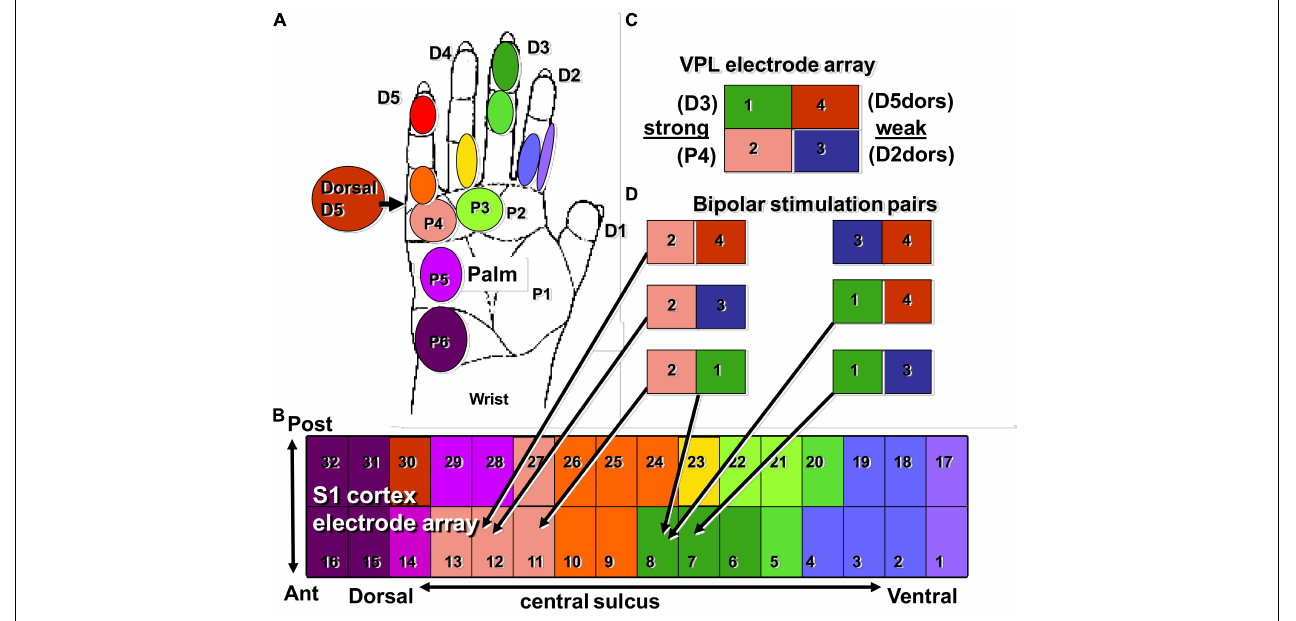
FIGURE 4 | S1 somatotopy in response to touch and VPL-MiSt. Shown are the results from 18 SFs recorded in S1 during 12 natural touch and 8 VPL-MiSt experiments (underlined, e.g., D4-Arm). VPL-MiSt was between two electrodes, where one electrode could have one SF, such as D4, and the other could be an Arm SF. Thus, the VPL-MiSt is labeled by both (D4-Arm). We have ordered the data in the expected somatotopic progression starting with D1. The color code at right depicts the z-scored significance for each point, e.g., 2 = p < 0.05 and 3 = p < 0.003 (see section “Materials and Methods”). See main text for reference to the points (A–I)